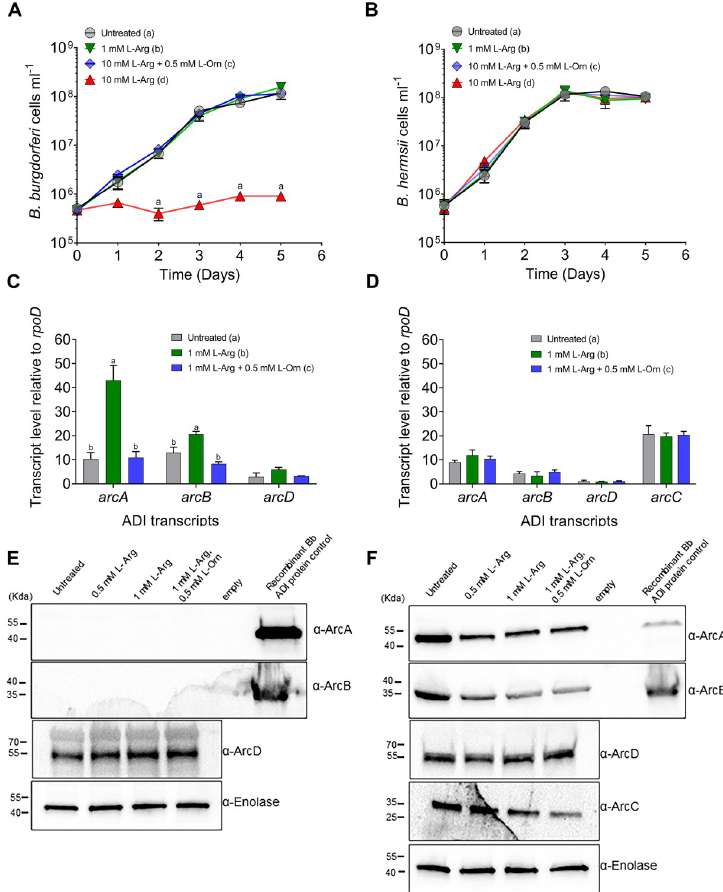
Fig 3. B . burgdorferi and B . hermsii respond differently to the presence of L-arginine and L-ornithine during in vitro growth. B . burgdorferi (A) and B . hermsii (B) were grown in the presence of exogenous L-arginine or L-arginine plus L-ornithine. Growth was monitored by dark field microscopy. Statistical analysis was performed using a repeated measures ANOVA with Dunnett correction for multiple comparison. Letters indicate p-value < 0.05 in multiple comparison testing. B . burgdorferi (C) and B . hermsii (D) were grown in the presence of exogenous L-arginine or L- arginine and L-ornithine combined and ADI gene transcription was assayed by qRT-PCR. Letters indicate p- value < 0.05 in a two-way ANOVA with a Tukey’s multiple comparison test. B . burgdorferi (E) and B . hermsii (F) ADI protein expression levels were assayed by western blot in: (1) untreated, mid-logarithmic phase cells or cells grown with exogenously added (2) 0.5 mM L-arginine, (3) 1 mM L-arginine, or (4) 1 mM L-arginine and 0.5 mM L-ornithine combined, (5) empty, (6) recombinant ArcA Bb or ArcB Bb . Primary antibody is indicated to right of each immunoblot panel and enolase is included as a loading